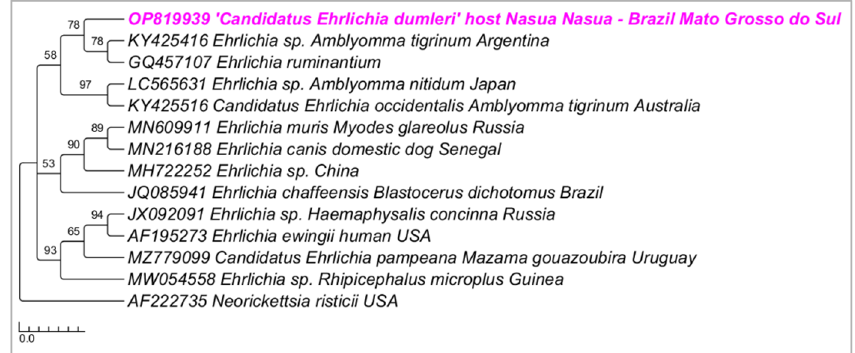
Figure 3. Phylogenetic tree inferred by the Bayesian method and based on the groEL gene from Ehrlichia spp. sequences obtained from blood from ring-tailed coatis ( Nasua nasua ) sampled in Campo Grande city, Mato Grosso do Sul state, Brazil. Sequences detected in the present study are highlighted in bold pink (VBA).